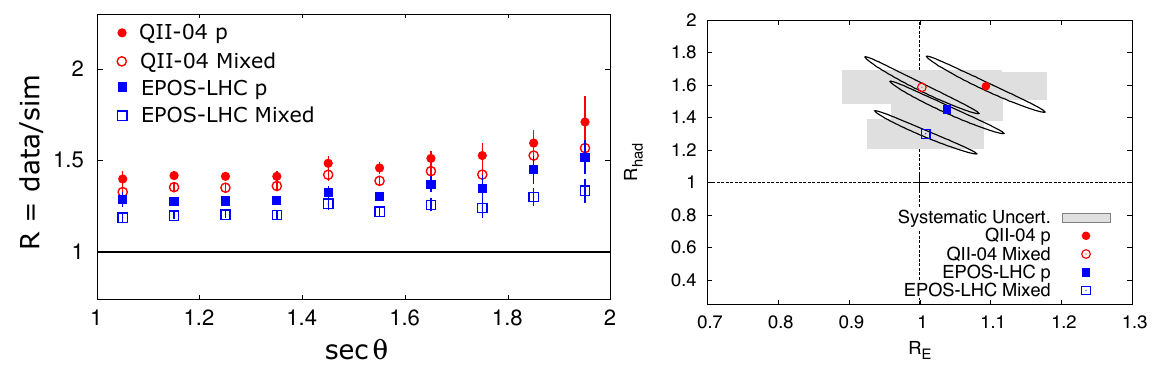
Figure 1. Results of the top-down analysis [8]. See text for